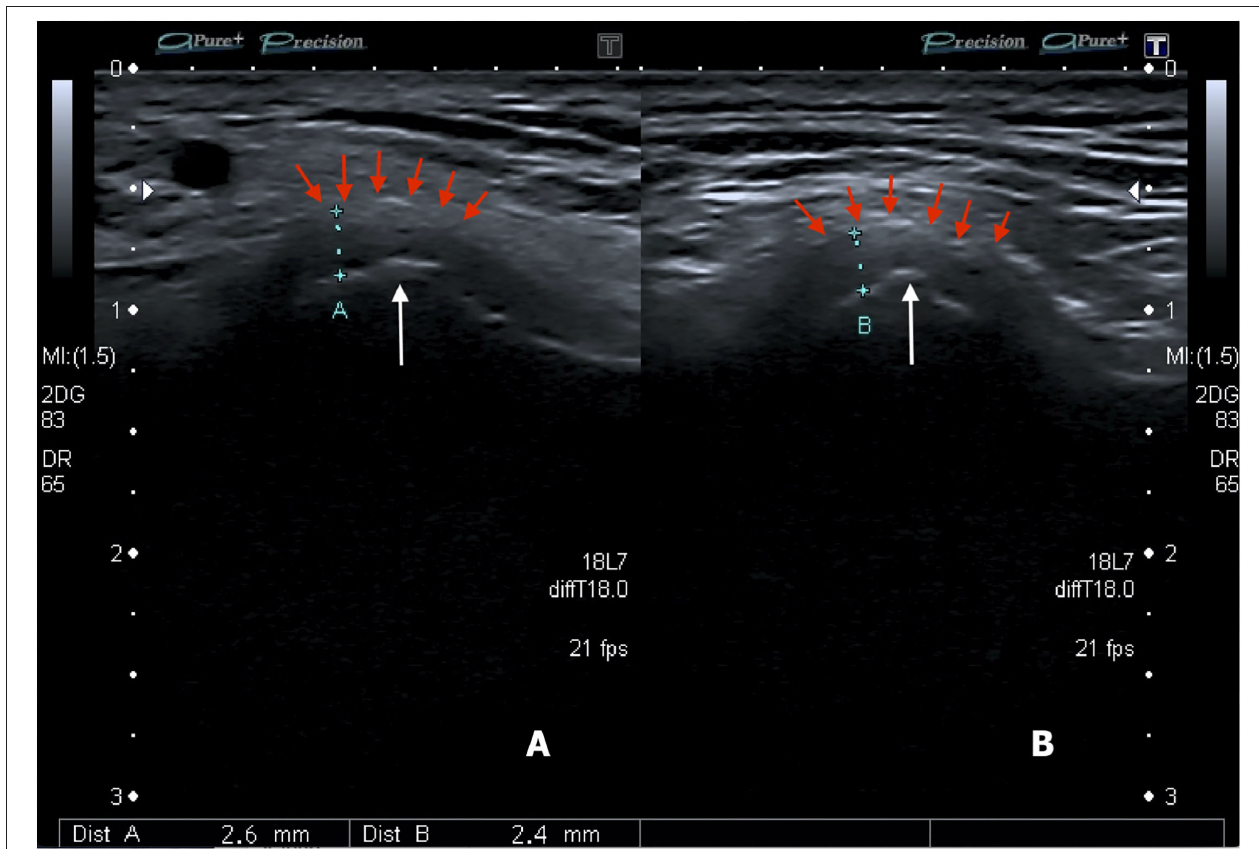
FIGURE 2 | Transverse image of the right (A) and left (B) TMJs showing the condyle and capsular width (distance between markers). White arrows show the condylar process and red arrows show the articular capsule (Personal